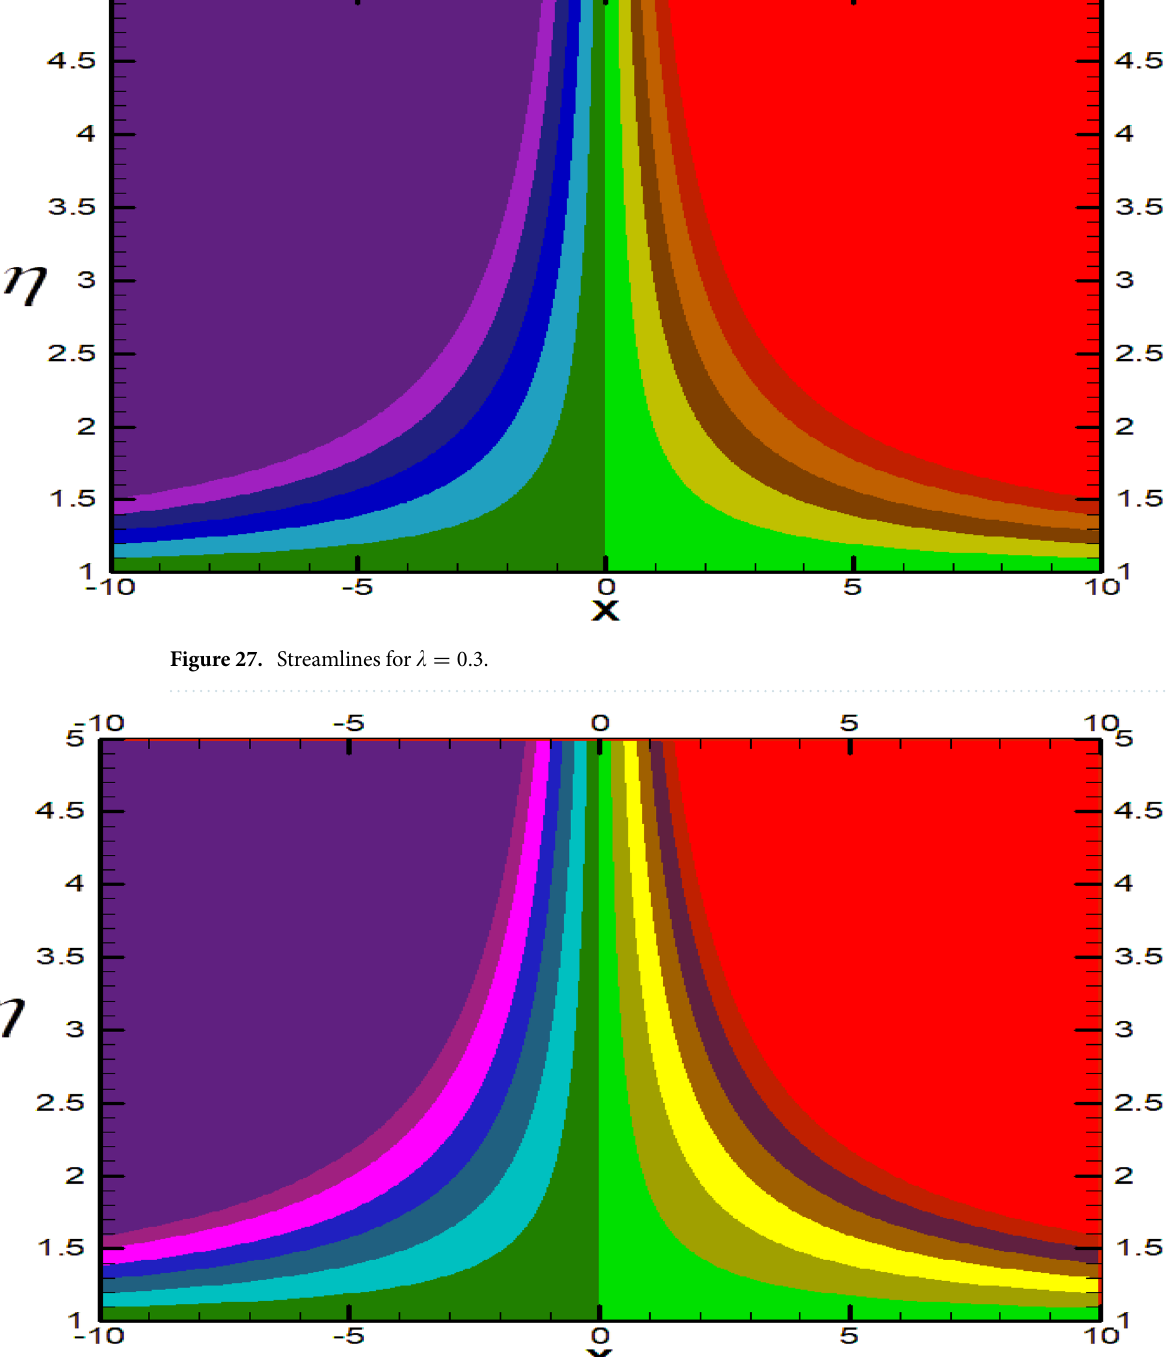
Figure 28. Streamlines for (cid:31)